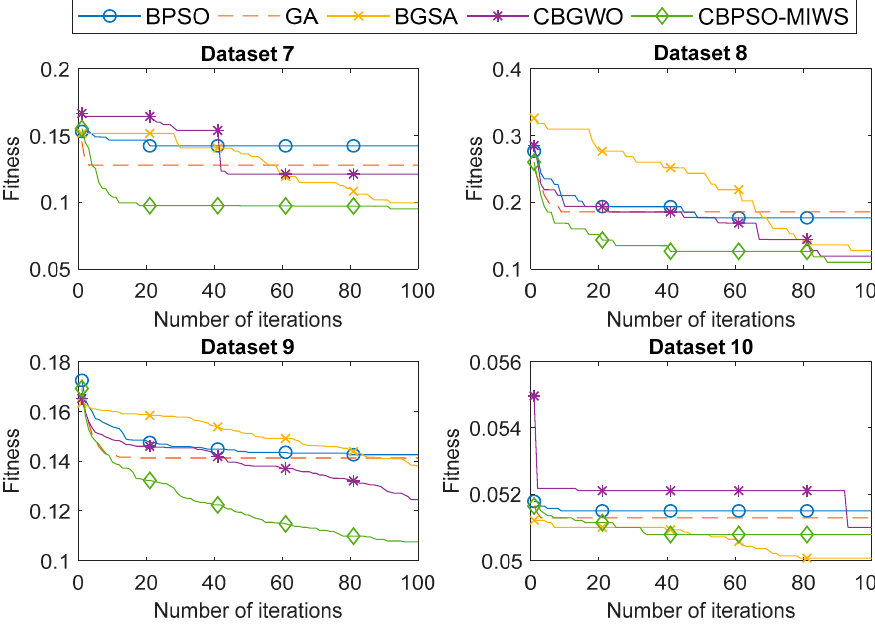
Figure 5. Convergence curves of five feature selection methods on datasets 7 to 10.